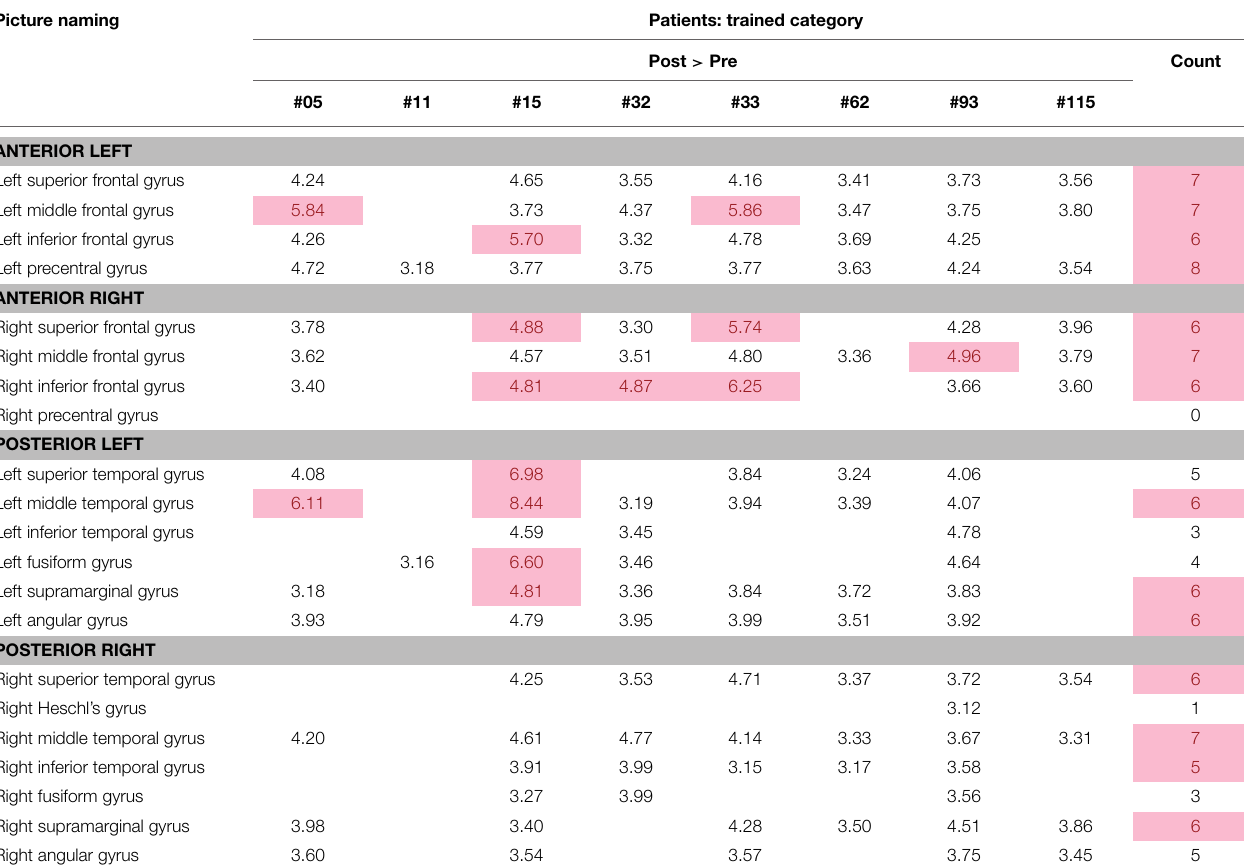
TABLE 6 | Regions of activation across patients in the post-rehabilitation > pre-rehabilitation contrast with T -values for the picture naming task. Picture naming Patients: trained